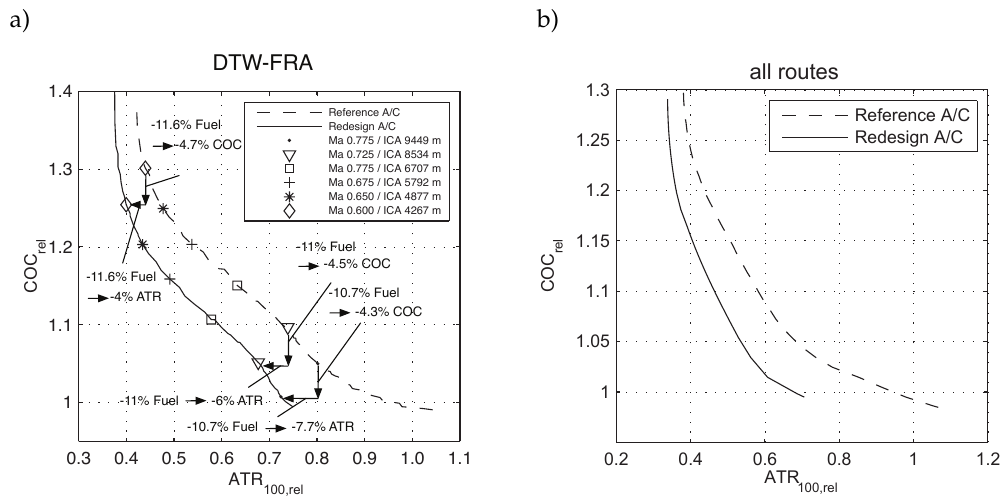
Figure 13. Pareto fronts for the reference and redesigned aircraft operated on route DTW-FRA ( a ) and operated on all analyzed routes ( b )